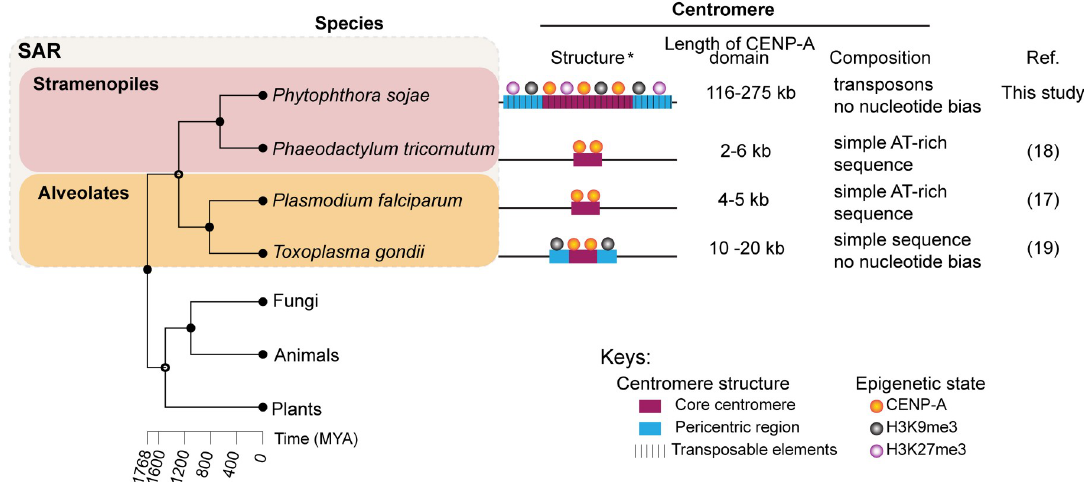
Fig 9. Diversity of centromere features within the Stramenopila-Alveolata-Rhizaria (SAR) supergroup. Simplified schematics (not to scale) showing the structures, epigenetic modifications, sizes and compositions of reported centromeres across the SAR lineages. Asterisk, epigenetic state was not examined in the diatom centromeric regions; however, several AT-rich DNA sequences can be employed for episome maintenance, suggesting diatom centromere might not be epigenetically dependent. The histone modification H3K27me3 was only tested in P . sojae . Phylogenetic tree was constructed using TimeTree [88]. Homo sapiens , Arabidopsis thaliana and Neurospora crassa were used as representatives of animals, plants and fungi for the phylogenetic analysis, and are used as outgroups illustrating the evolutionary status of the SAR supergroup.